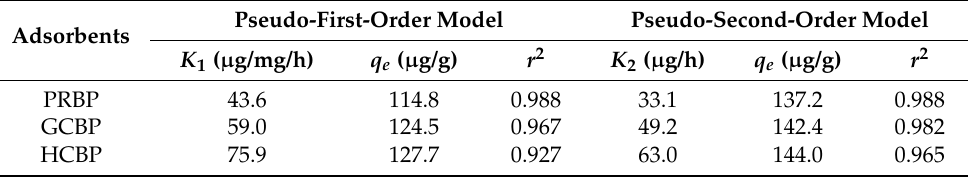
Table 2. The adsorption kinetics parameters of DCF onto PRBP, GCBP, and HCBP. Pseudo-First-Order Adsorbents